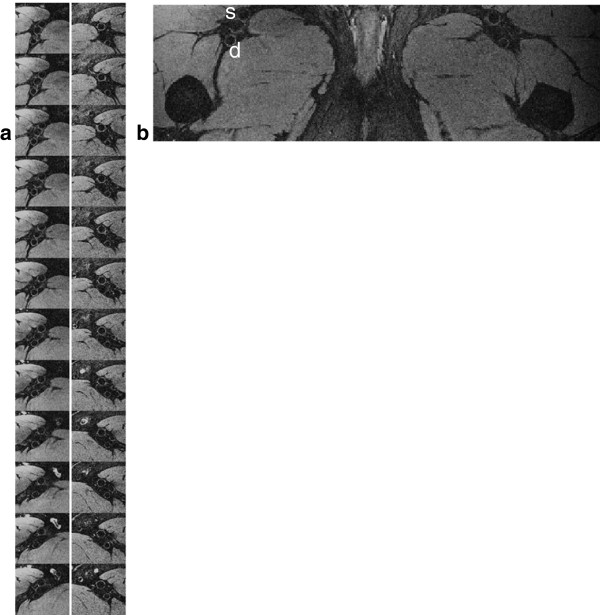
Bilateral vessel-wall images of deep (d) and superficial (s) femoral arteries of a healthy 54 year-old subject. a) Twelve contiguous slices (cropped) below the common femoral artery bifurcation; b) expanded view of fourth row in a).